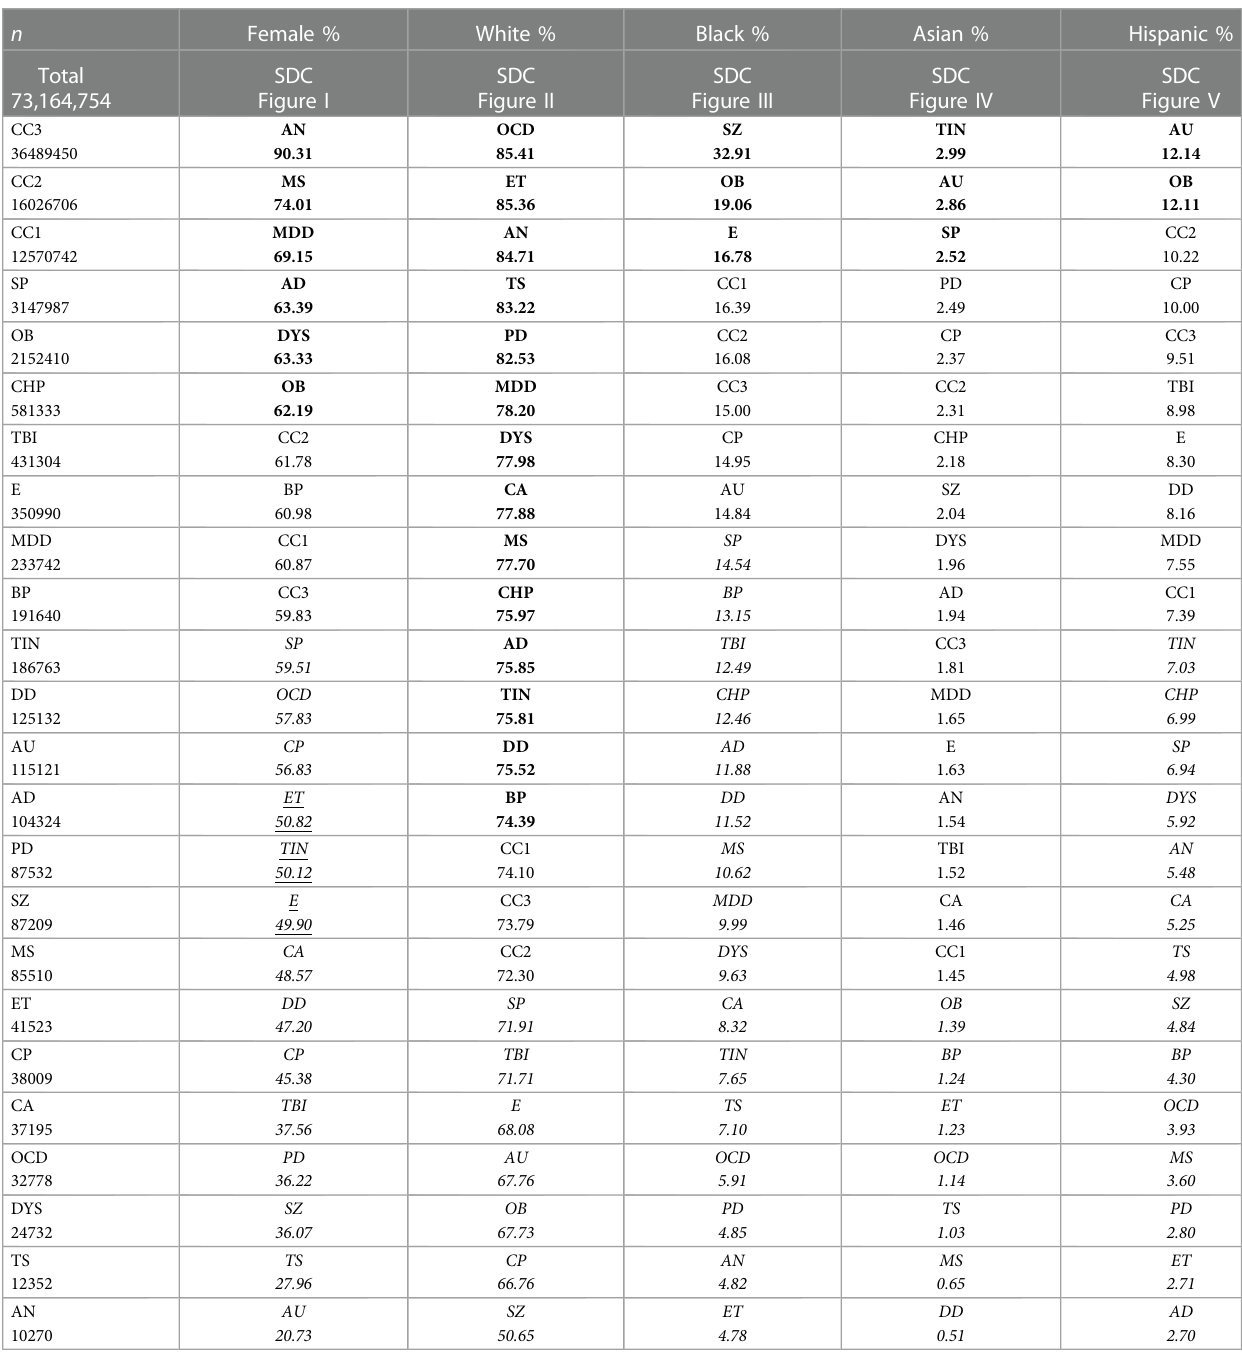
TABLE 4 Total surgeries and